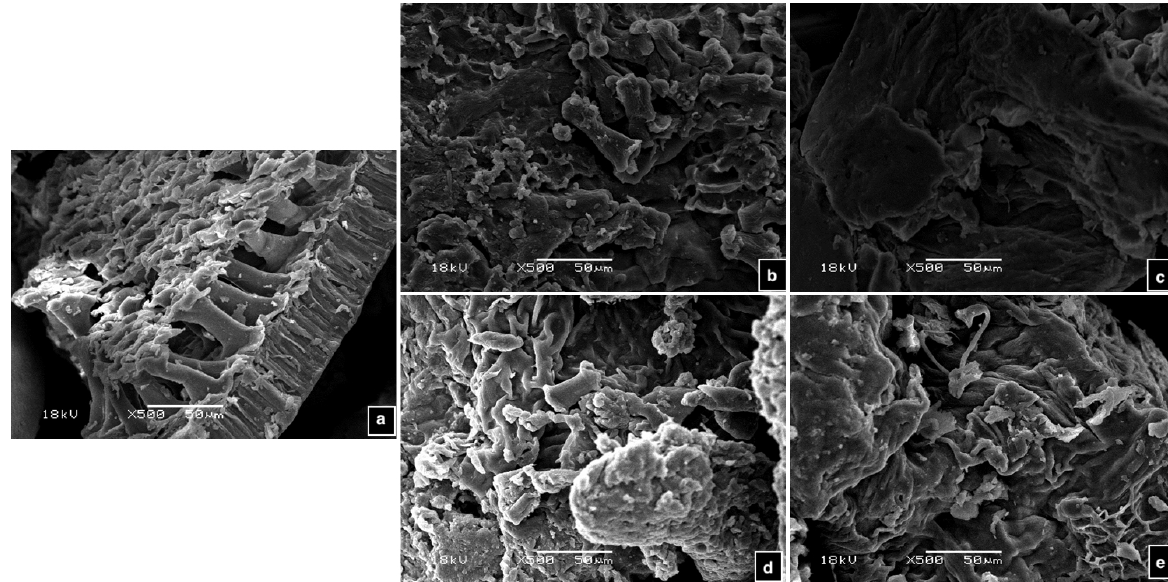
Figure 9. SEM comparison of soybean hull samples before and after treatment using IL (500 times magnification). (a) Untreated soybean hull outer surface; (b) treatment at 100 °C, 2 h, using [bmim][Ac]; (c) treatment at 100 °C, 6 h, using [bmim][Ac]; (d) treatment at 100 °C, 2 h, using [bmim][Cl], (e) treatment at 100 °C, 6 h, using